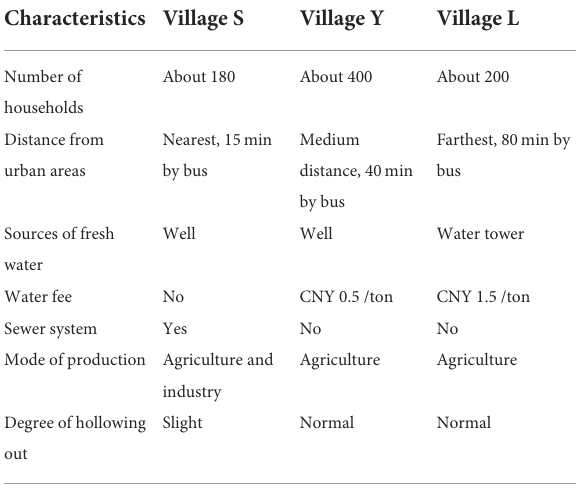
TABLE 1 Descriptions of the three villages in the